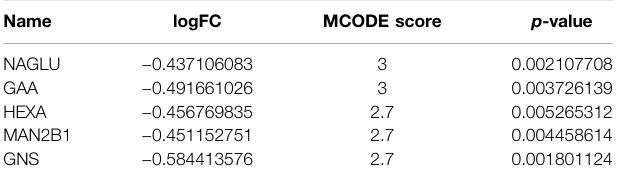
TABLE 1 | Identi fi cation of the top 5 hub genes of DRGs in the PPI network using MCODE analysis.